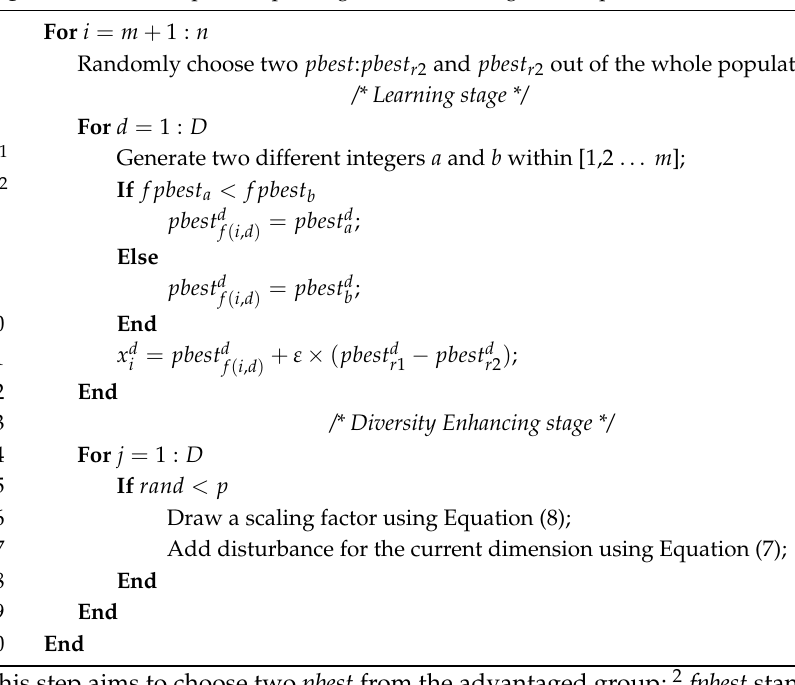
Algorithm 1. The Steps for Updating the Disadvantaged Group